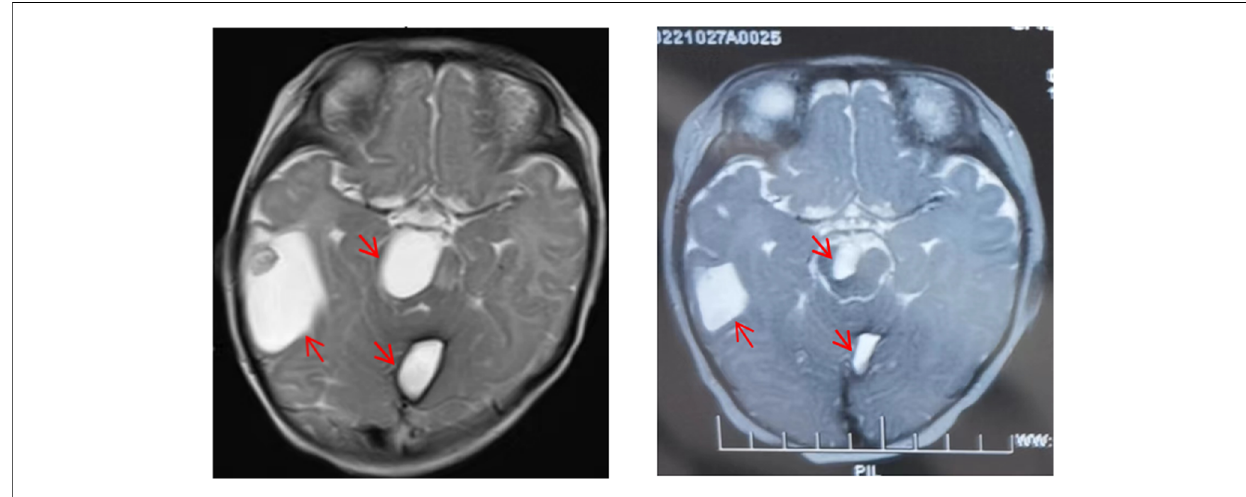
FIGURE 2 Comparison of lesions on head magnetic resonance imaging (MRI) before and after treatment. Lesions on head MRI before treatment ( A ) and after treatment ( B